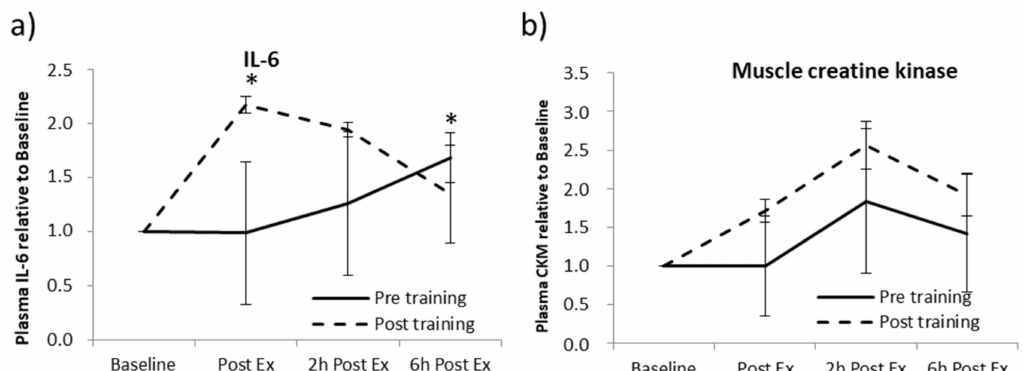
Figure 2. Modulation of IL-6 ( a ) and Creatine Kinase M-type systemic level ( b ) in response to an acute aerobic exercise in sedentary and trained subjects. The assays were performed at steady state (baseline), immediately after physical activity (Post Ex), after 2 (2 h Post Ex), and 6 h (6 h Post Ex) subsequently the end of the exercise. Values are mean ± SE. * significant difference from baseline ( p <